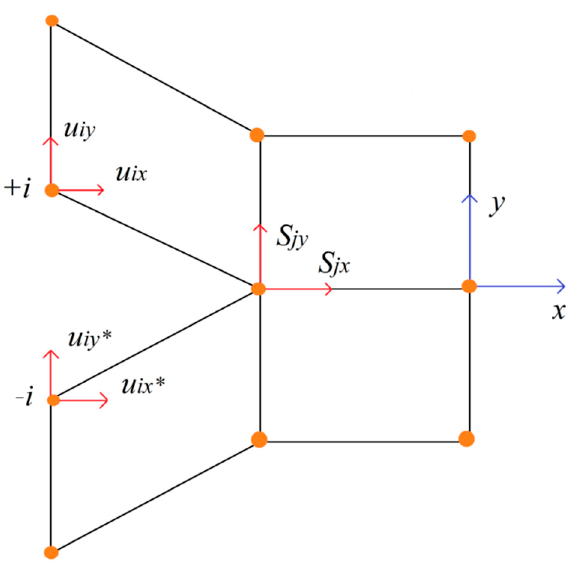
Figure 5. Two-dimensional representation of the VCCT technique.